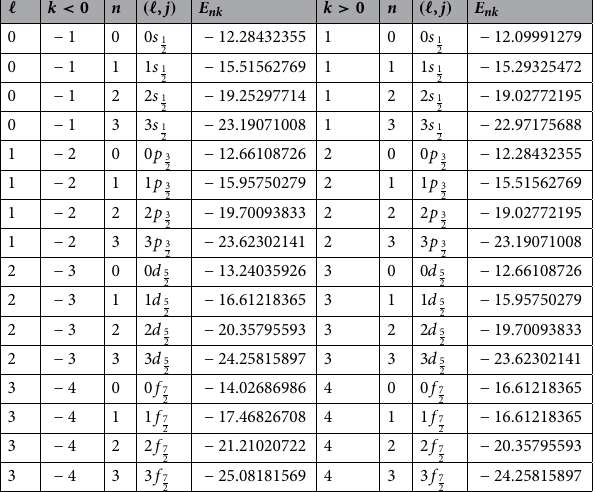
5 fm − 1 , v 1 15 fm − 1 , b = =